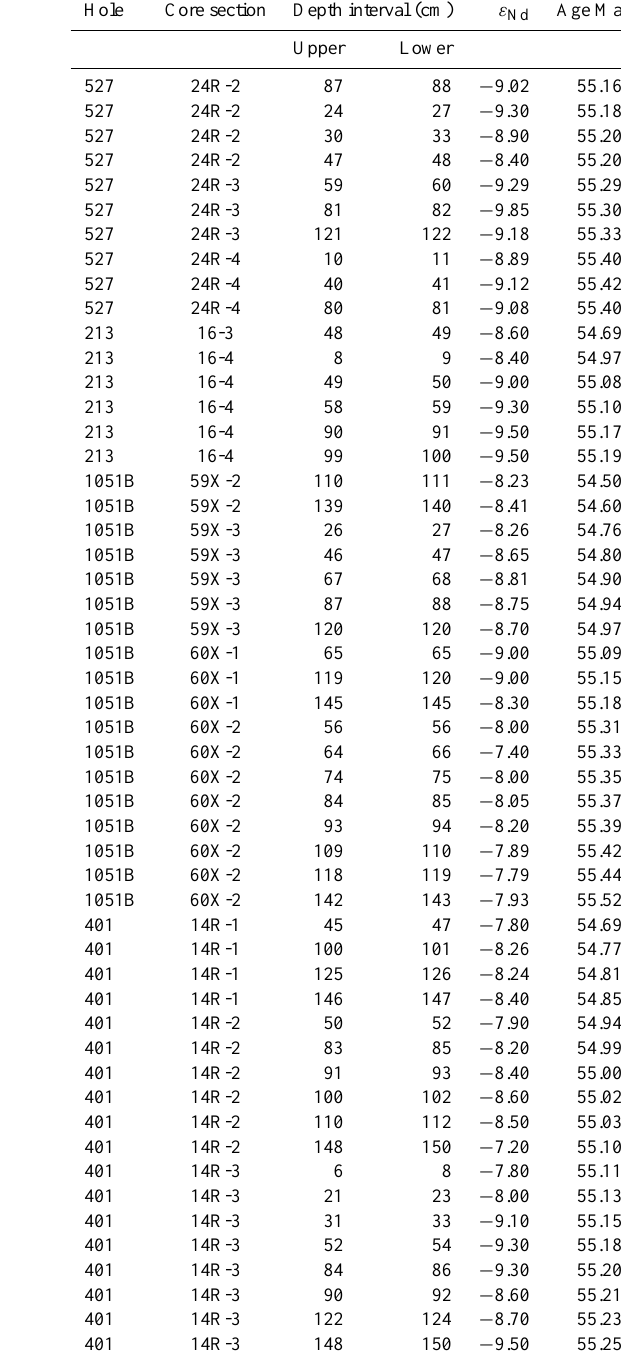
Table 3. Summary of neodymium isotope data. Sample description and ε Nd